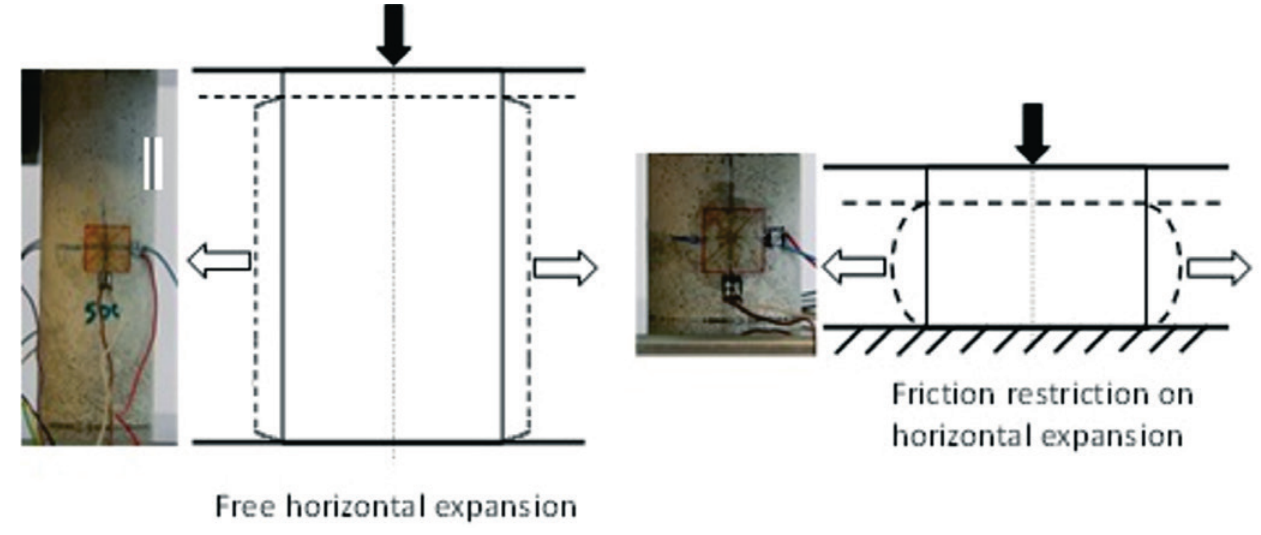
Figure 18 Differences in the horizontal displacement of the